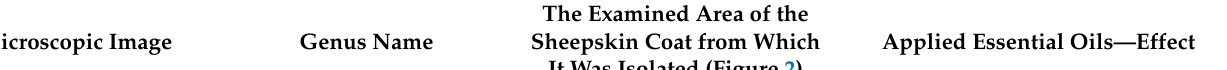
Table 2. Identified fungi and the effect of essential